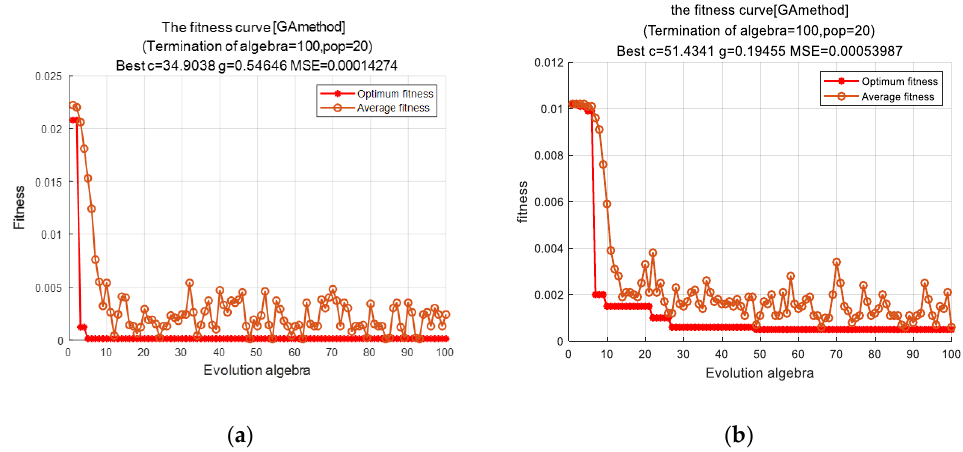
Figure 14. The fitness curve of GA method. ( a ) Results for T V u / 20 V u ratio; ( b ) Results for T V e / 20 V e ratio.